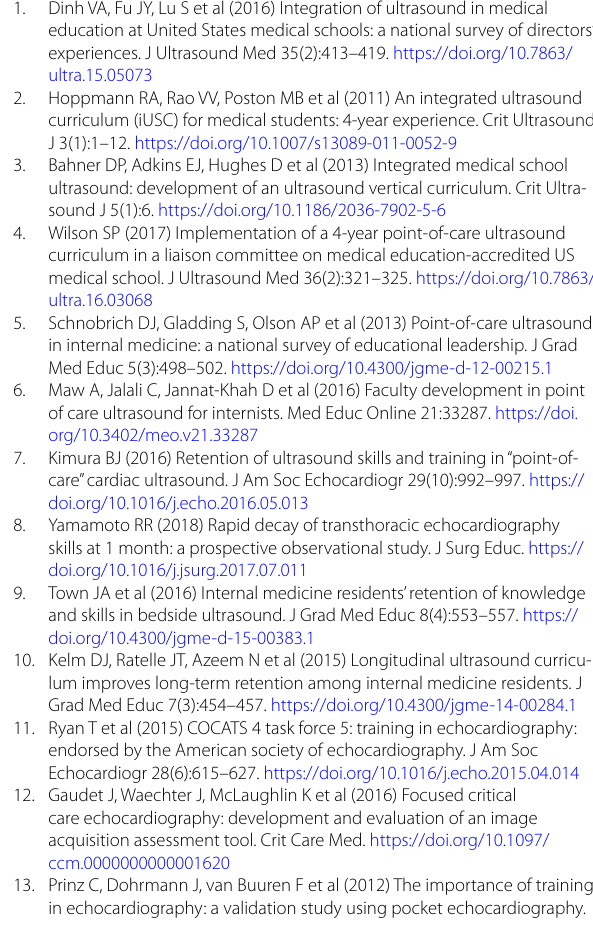
figure design. AM and CB: ultrasound exam scoring. EL: statistical analysis. All authors participated in manuscript editing. All authors read and approved